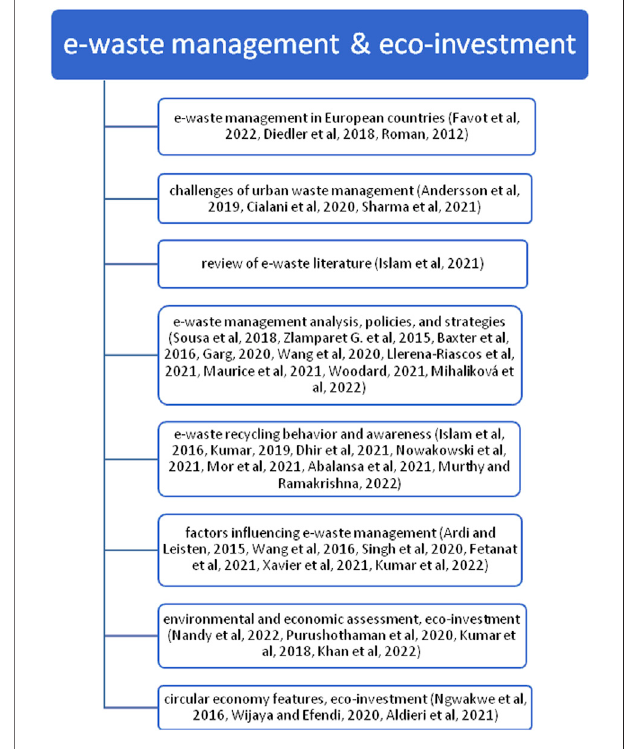
FIGURE 1 | Scienti fi c literature development/Source: Created by the